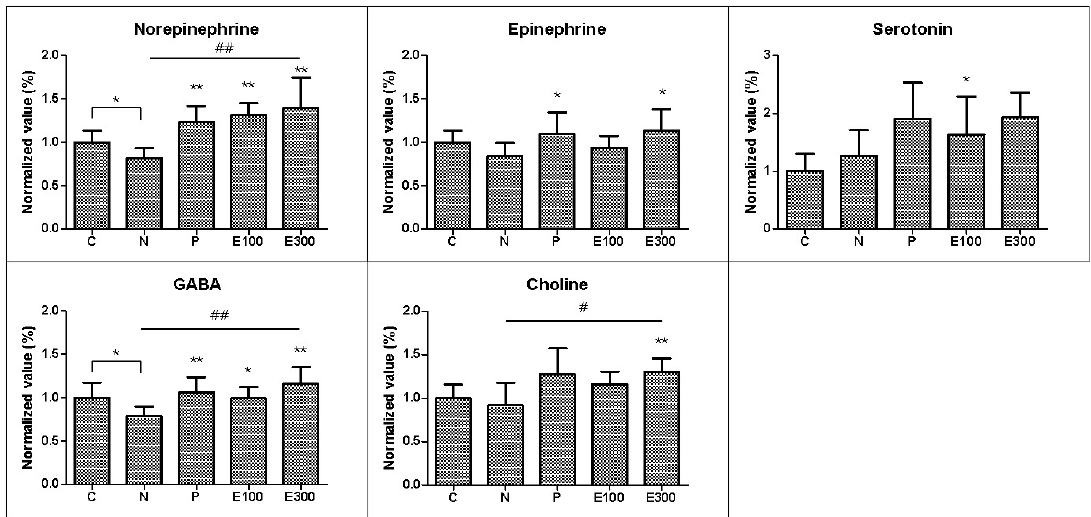
Figure 4. LC-MS/MS analysis of neurotransmitters in the hippocampi of mouse brains after behavioral tests by intraperitoneal injection of fluoxetine and oral administration of the extract into mice ( n = 7). C: normal control; N: negative control (CUMS); P: positive control (CUMS + 15 mg/kg fluoxetine); E100 and E300: doses of the extract (CUMS + 100 and 300 mg/kg, respectively). GABA: γ -amino butyric acid. #: Kruskal-Wallis test; *: Mann-Whitney test. #: p < 0.05; ##: p < 0.01; *: p < 0.05; **: p < 0.01.